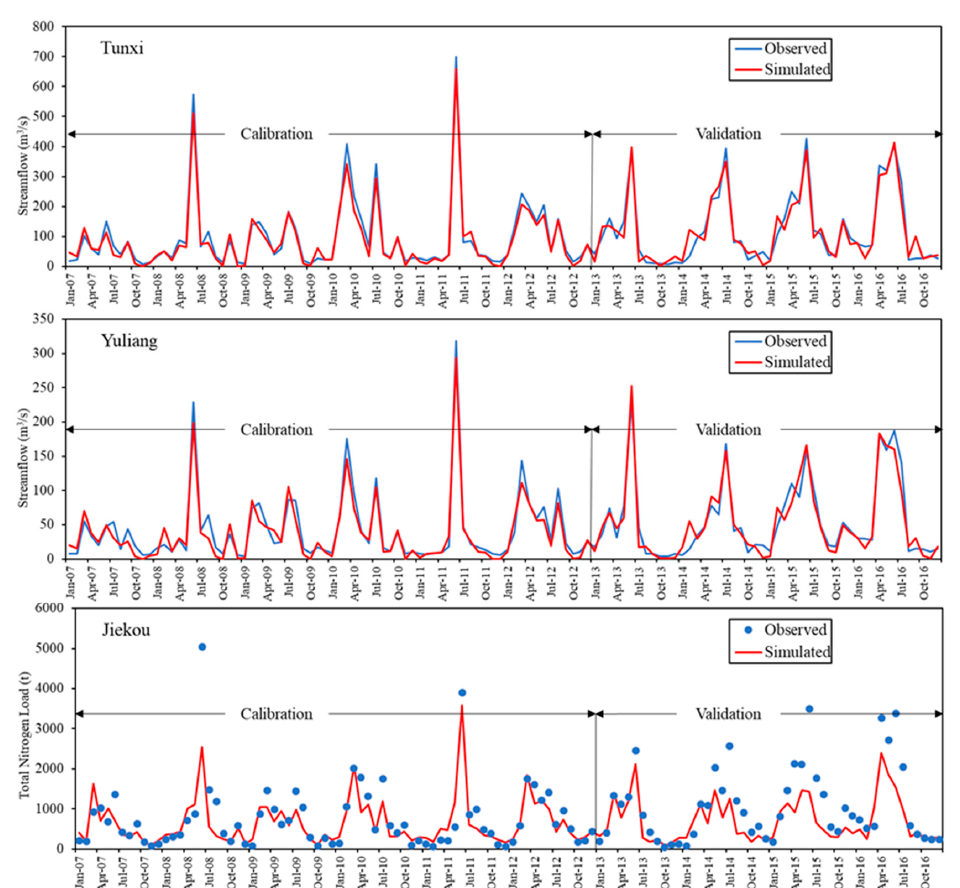
Figure 3. Observed and simulated daily streamflow values at Tunxi and Yuliang, and observed and simulated monthly TN loads at